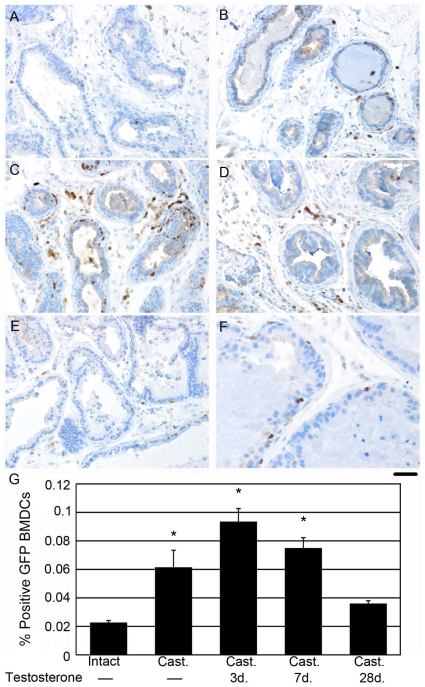
BMDCs were recruited to the prostate during regrowth.GFP-BMDC (brown) recruitment was localized in prostates of GFP chimeric mice. BMDCs were quantitated in prostates of A) intact mice, B) two months post-castration, C) castrated mice supplemented with exogenous testosterone for three days, D) castrated mice supplemented with exogenous testosterone for seven days, and E) castrated mice supplemented with exogenous testosterone for 28 days. F) Higher magnification of castrated prostates supplemented with exogenous testosterone for 28 days indicated BMDC recruitment to the epithelial ductal compartment. Scale bar indicates 50 µm for panels A–E and 25 µm for panel F. G) The bar graph quantifies the percentage of GFP-positive BMDCs recruited to the prostate at the indicated time points during regrowth. Oneway ANOVA was performed to test differences between the experimental and control groups (n = 3 per group), followed by Dunnett's post-hoc tests. Statistically significant values are indicated with * in the bar graph. Error bars indicate standard deviation. The omnibus of F statistic from the ANOVA was 43.3 with 4 and 10 degrees of freedom (p<0.0001). Dunnett's post-hoc tests showed differences between intact (mean  = 0.0227) and castrated (cast) (mean  = 0.0615) (p<0.0003), cast +3dT (mean  = 0.00936) (p<0.0001), and cast +7dT (mean  = 0.0750) (P<0.0001). The intact group did not differ from cast +28dT (mean  = 0.0360) (p<0.1629).